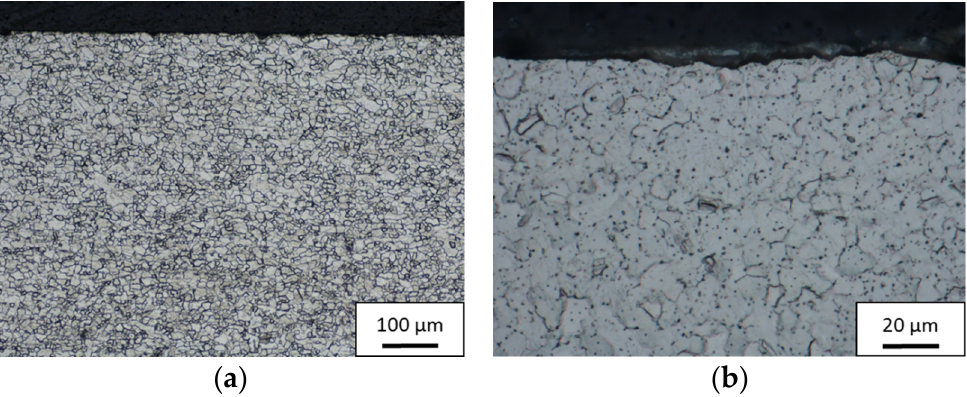
Figure 9. Microstructure of as-received titanium Grade 4: ( a ) longitudinal cross-section, ( b ) transverse cross-section—optical light microscopy.